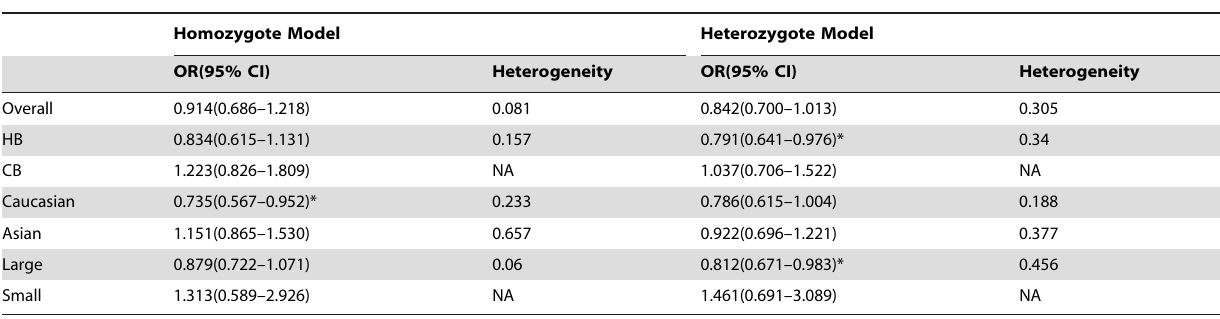
Table 4. Meta-Analysis Results of XPC PAT